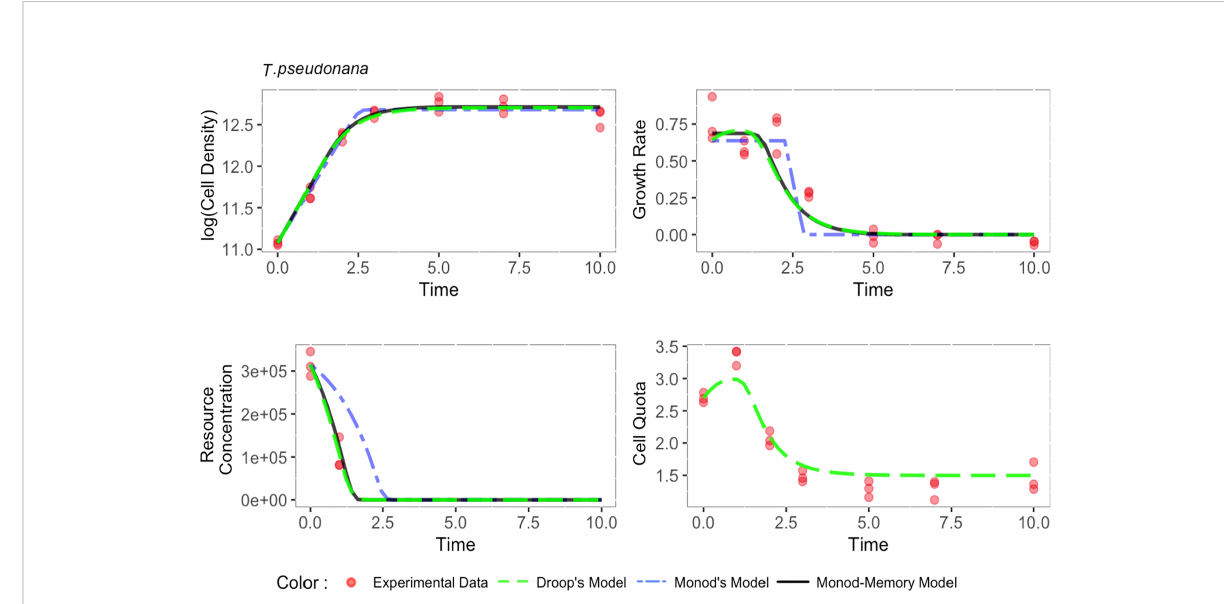
FIGURE 2 Comparison of estimated population dynamics fi t to experimental data collected on Thalassiosira pseudonana in batch culture (Liefer et al., 2019). MSE value and the optimum coef fi cients are given in Tables S5, S4.